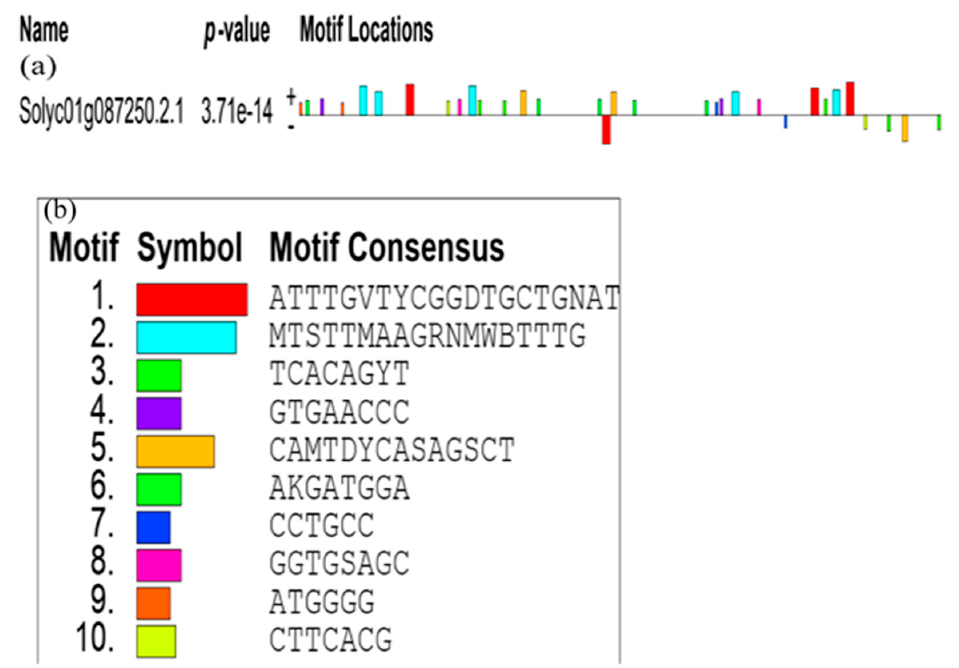
Figure 6. The conserved domains of the SlCCD1A amino acid sequences: ( a ) conserved domains and ( b ) amino acid sequences of the conserved domains.